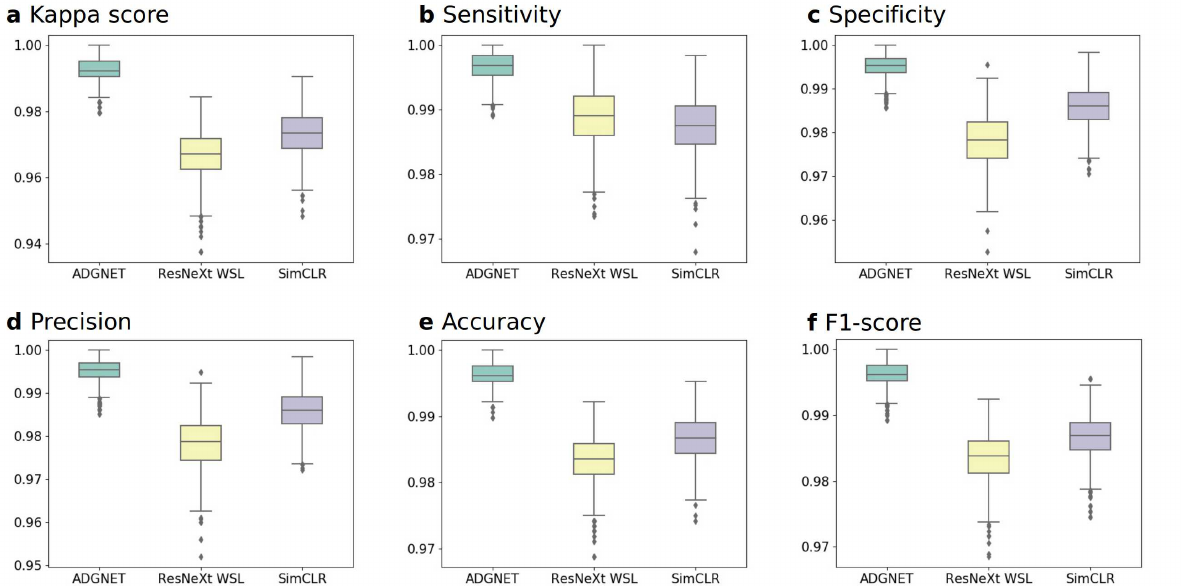
Figure 5. Boxplots of the six evaluation metrics of the models in experiment A. ( a ) kappa score. ( b ) sensitivity. ( c ) specificity. ( d ) precision. ( e ) accuracy. ( f )